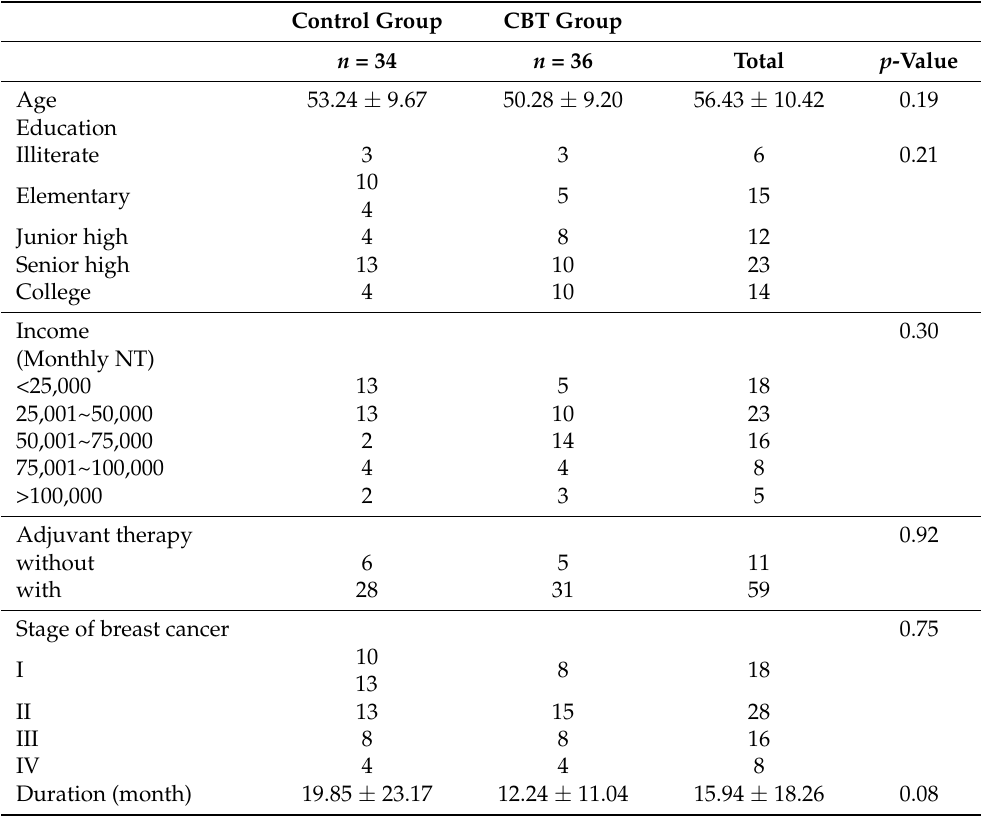
Table 1. The Comparison of Demographic and Clinical Features between Two